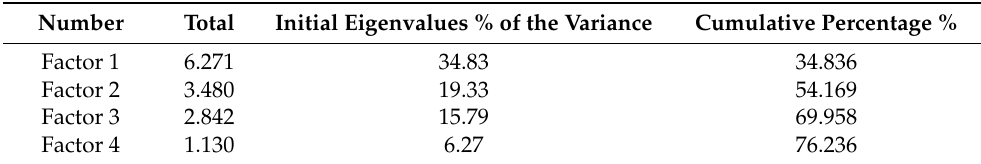
Table 4. The portion of variation that can be attributed to each specific component after rotation